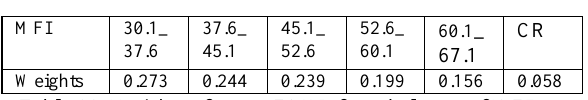
Figure 10. Final flood risk map Figure 11 shows the flood risk map with 95% probability.